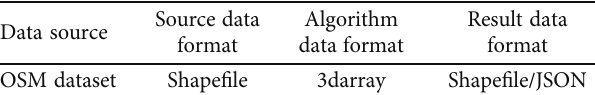
Table 2: Data source and